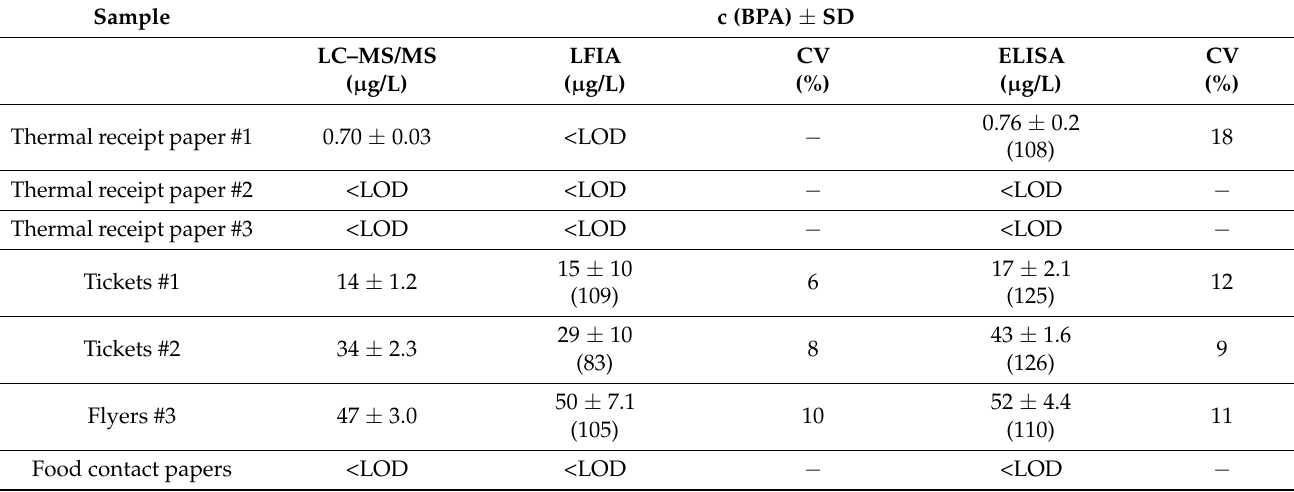
Table 3. Analytical results of selected samples (n = 3 replicates). The values of BPA found with LC–MS/MS, ELISA, and LFIA are shown. Information in brackets indicates the recovery rate (BPA in relation to LC–MS/MS) of the immunoassays.